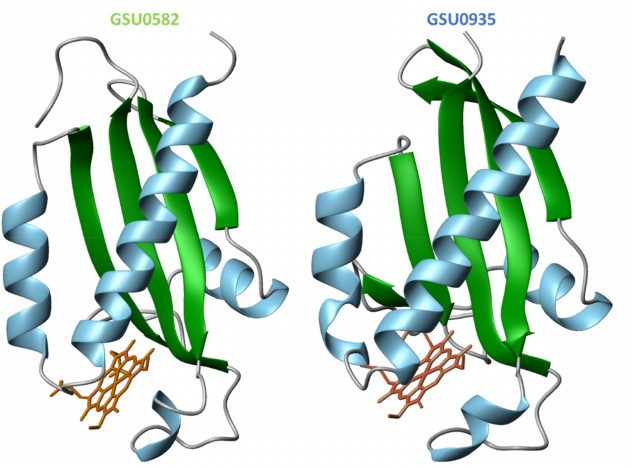
Figure 14. GSU0582 and GSU0935 predicted monomer models constructed using the program 3D- PSSM. The two helical segments at the N-terminal followed by four-stranded antiparallel β -sheets are represented in blue and green, respectively. The heme groups are represented in